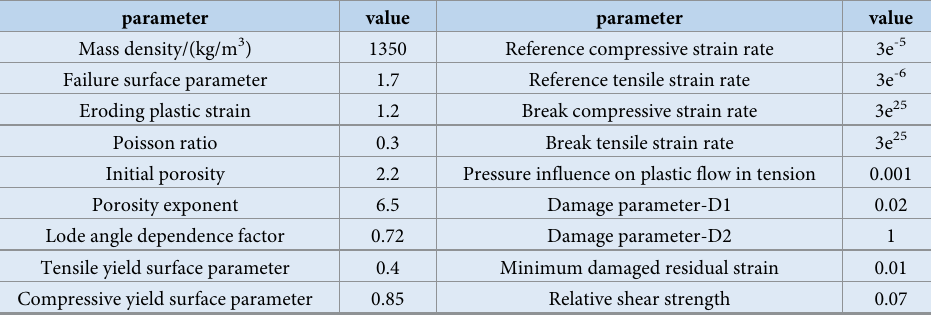
Table 1. Parameters related to coal rock materials.